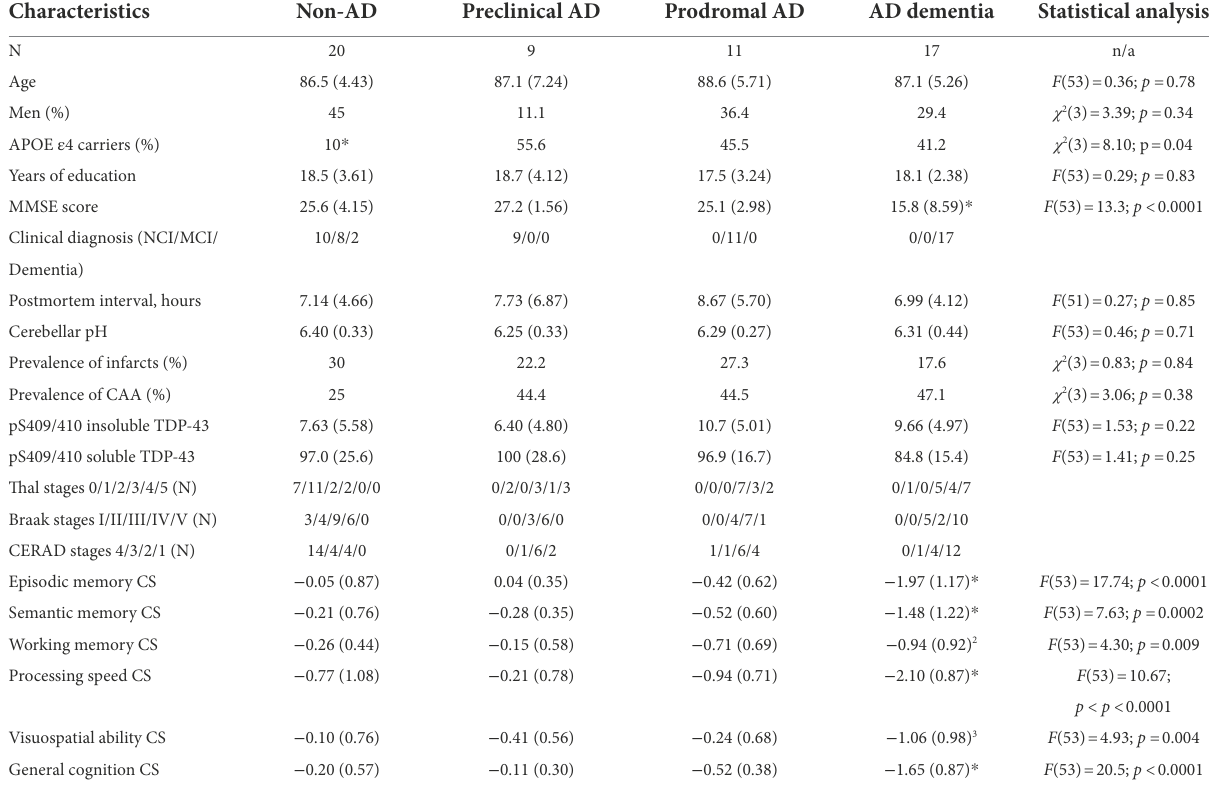
TABLE 1 Characteristics of subjects classified by clinicopathologic stages of